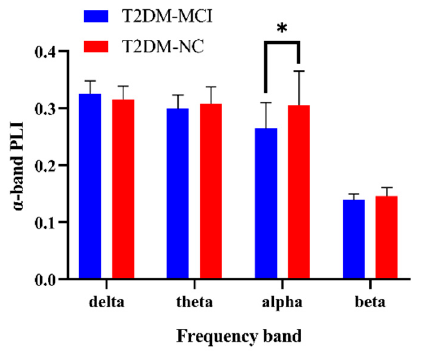
Figure 1. The phase lag index of all pairs of EEG channels in four frequency bands between T2DM- MCI and T2DM-NC patients. The T2DM-MCI group and T2DM-NC group are shown in blue and green boxes, respectively. Error bars are standard deviations. * p < 0.05.